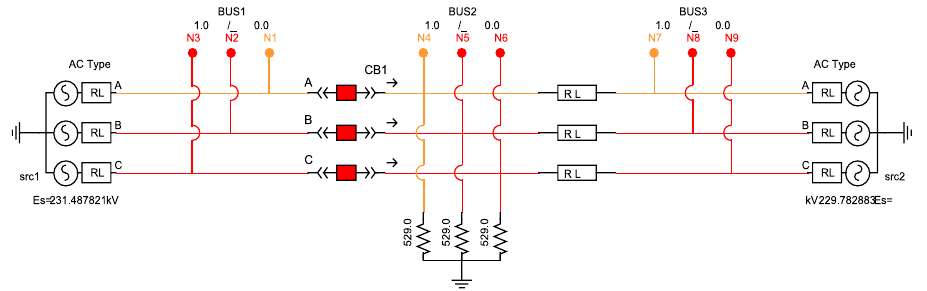
Figure 6. 3-phase doubly fed system in RSCAD Draft with 3 buses, circuit breaker, isolators and load 6 .